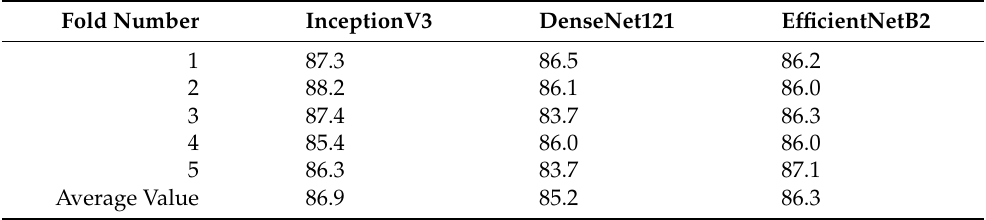
Table 10. Validation accuracy of single Chinese character multi-category classification of stopping